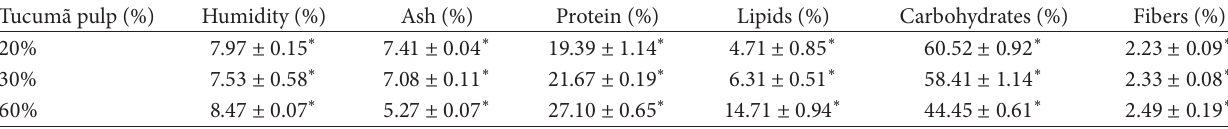
Table 2: Physicochemical characterization of the dry food portion based on tucum˜a pulp concentration.